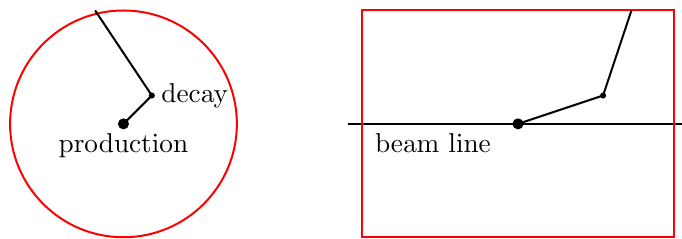
Figure 13 . Process where a long-lived highly charged state decays to a collider-stable singly charged state, leading to events where activity in the muon chambers is not aligned with the charged track. (Left): view along the beam pipe. (Right): transverse view. The red lines show the edges of the detector. As discussed in the text, these events are di(cid:14)cult to identify and lead to a weakening of limits around (cid:1) m 1 (cid:24) 20{30